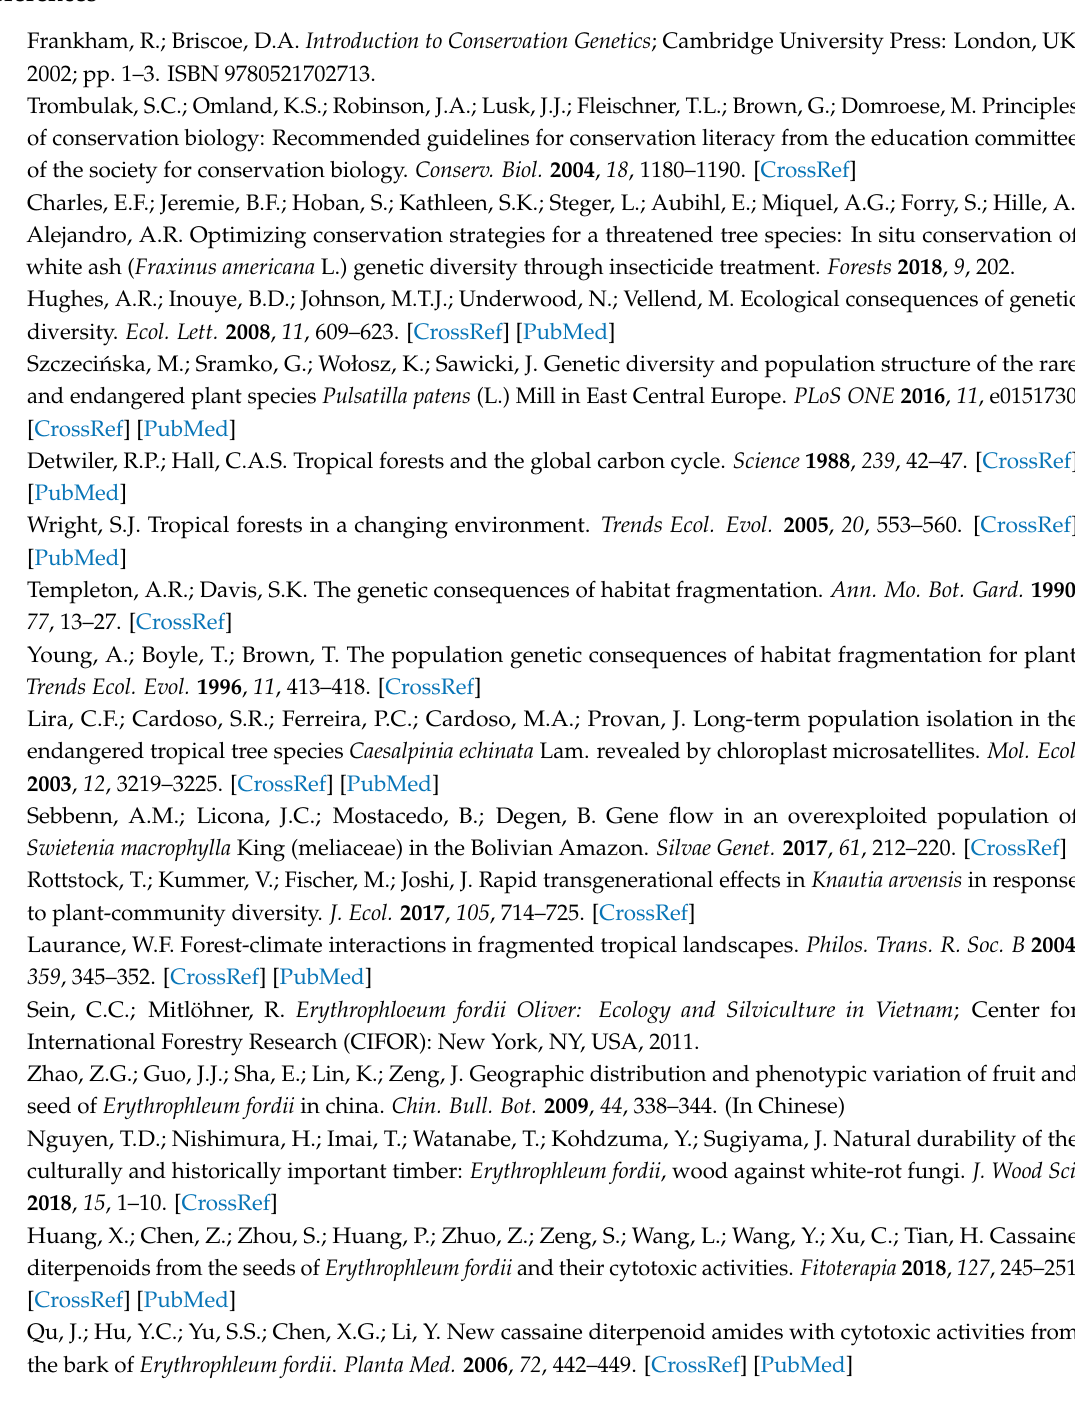
Table S1: Description of five SSR primers for Erythrophleum fordi